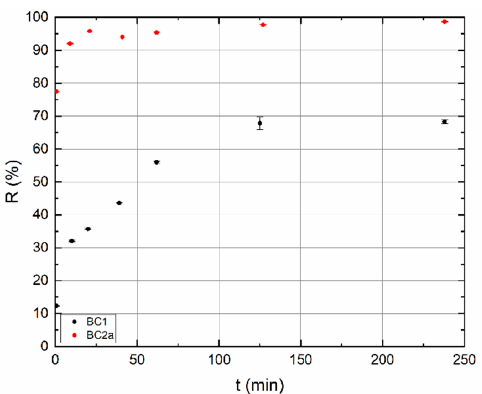
Figure 5. Sorption percentage ( R ) as a function of pH or pH eq. ( a ) BC1, and ( b ) BC2a. t = 24 h.